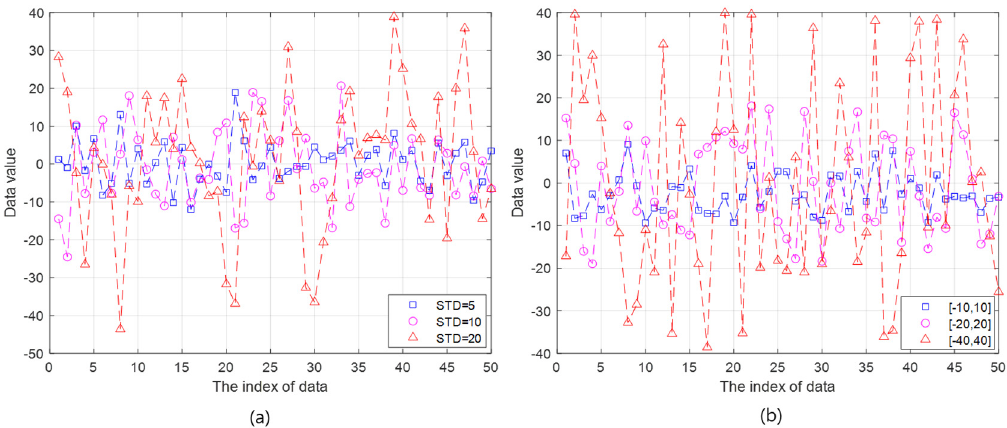
Figure3. Theillustrationofgenerateddatatocheckthefeasibilityofpartialinitialization. ( a )Therandom Figure 3. The illustration of generated data to check the feasibility of partial initialization. ( a ) The data with normal distribution. ( b ) The random data with uniform random data with normal distribution. ( b ) The random data with uniform distribution.